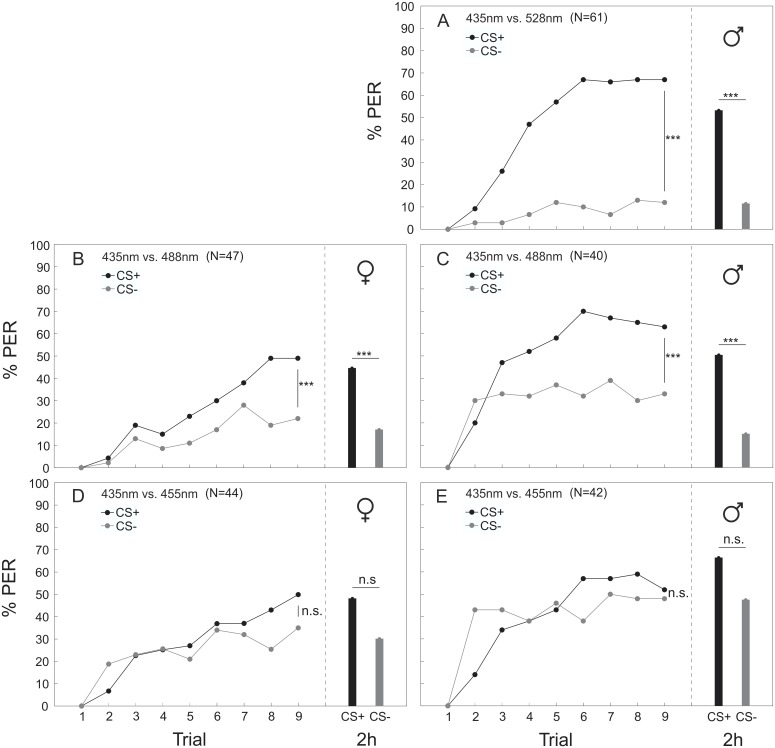
Differential color conditioning and memory retrieval in workers and drones.Three different monochromatic color stimuli combinations (435/528 nm; 435/488 nm and 435/455 nm) with different wavelength distances (93 nm; 53 nm and 20 nm) between stimuli were tested. Bumblebees were trained to discriminate the rewarded (CS+) and the unrewarded color stimulus (CS-). Each color stimulus combination was tested reciprocally. For the memory retrieval test the rewarded color stimulus (CS+: black bar) and the unrewarded color stimulus (CS-: gray bar) were presented to the bees 2 h after end of conditioning. Since no effects of asymmetrical discrimination between the two colors of each combination was found (except for 435/528 nm in workers, see Fig 5), data were pooled. *** P < 0.001; n.s.: not significant.